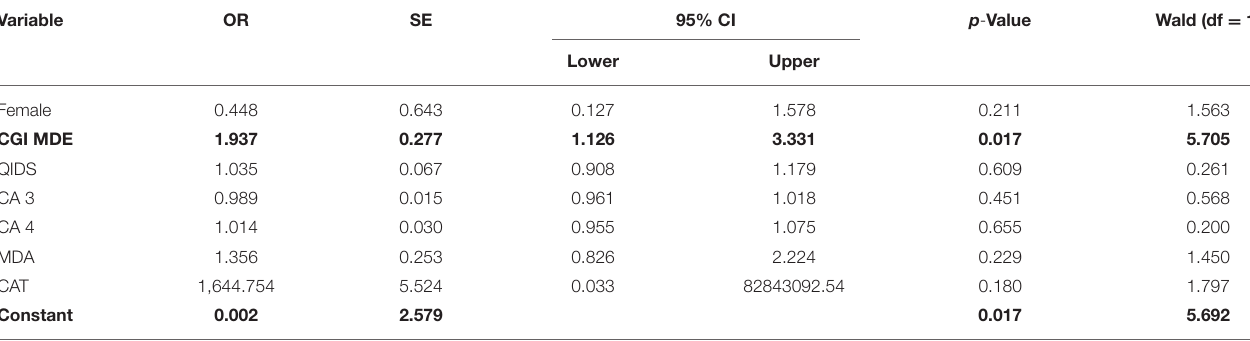
TABLE 3 | Effects of demographic factors, clinical factors, and oxidative stress on lifetime suicidal ideation using multivariate binary logistic regression analysis. Variable